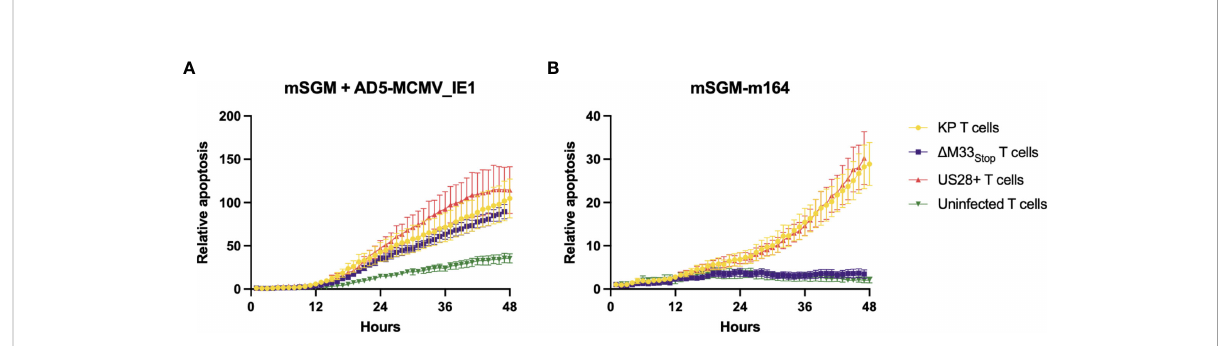
FIGURE 5 Fewer m164 epitope-speci fi c T cells from mice latently infected with D M33 stop result in decreased cytotoxicity, and this defect is rescued by US28. MACS-enriched T cells from mice infected with KP (yellow), D M33 stop (purple), or US28 + (red) MCMV or left uninfected (green) were added at an effector:target ratio of 6:1 to mSGM mesenchymal cells infected with Ad5-MCMV_IE1 (A) or mSGM-m164 cells (B) . Apoptosis is shown as a ratio compared to time 0 and normalized to con fl uence of the cell